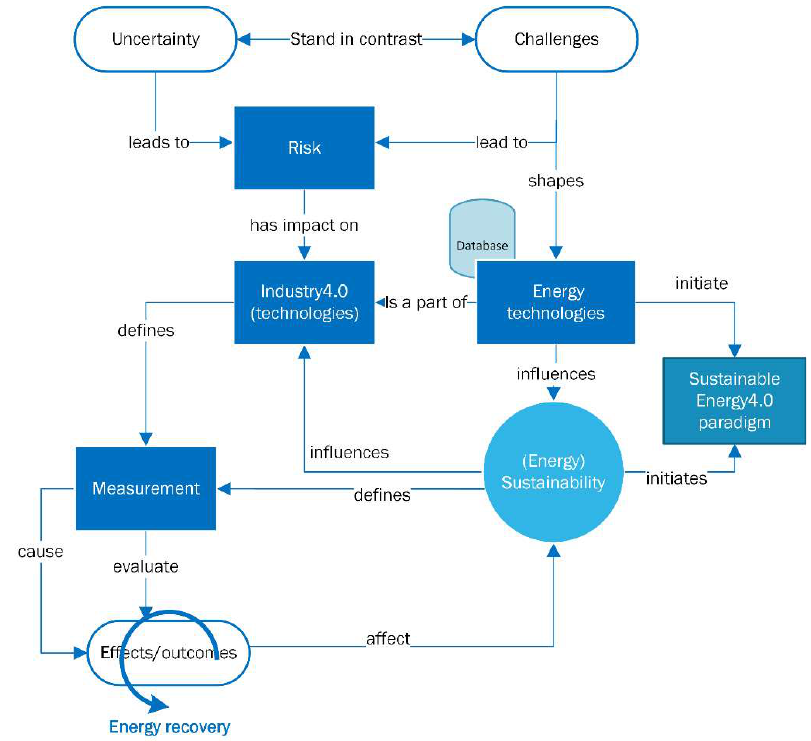
Figure 3. Relationships network.